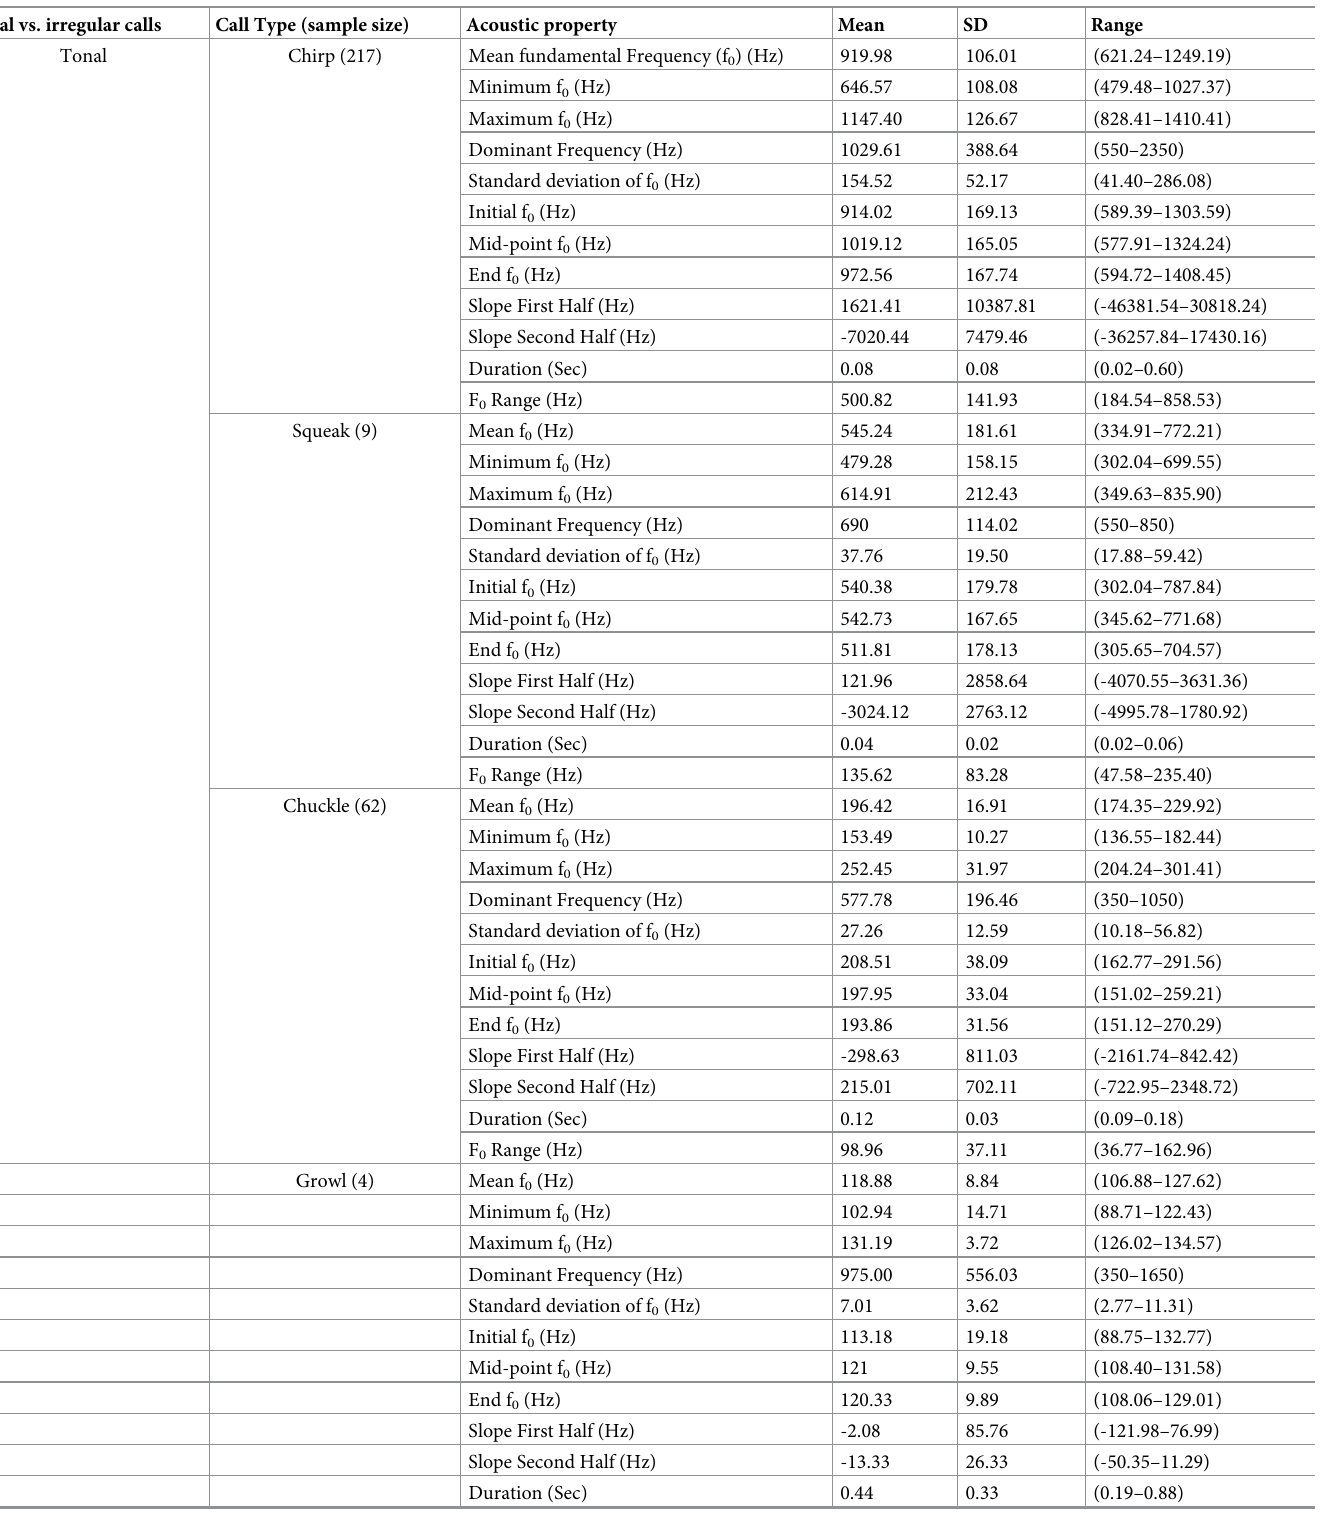
Table 3. Means, standard deviations (SD) and ranges for 12 (Tonal calls) and 4 (NLP calls) acoustic parameters of otters’ calls. Tonal vs. irregular